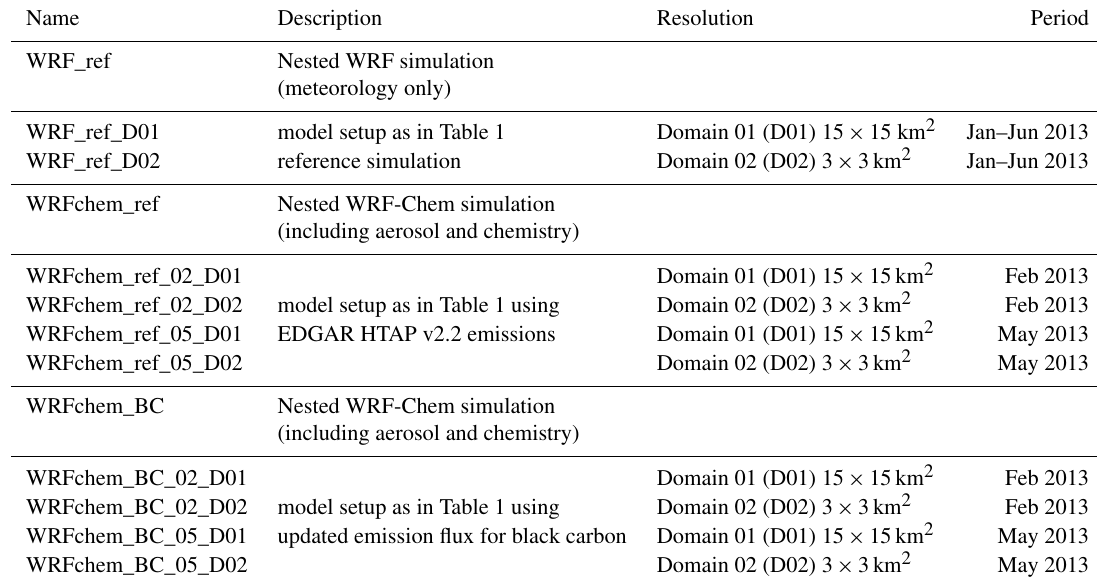
Table 2. WRF and WRF-Chem simulations.